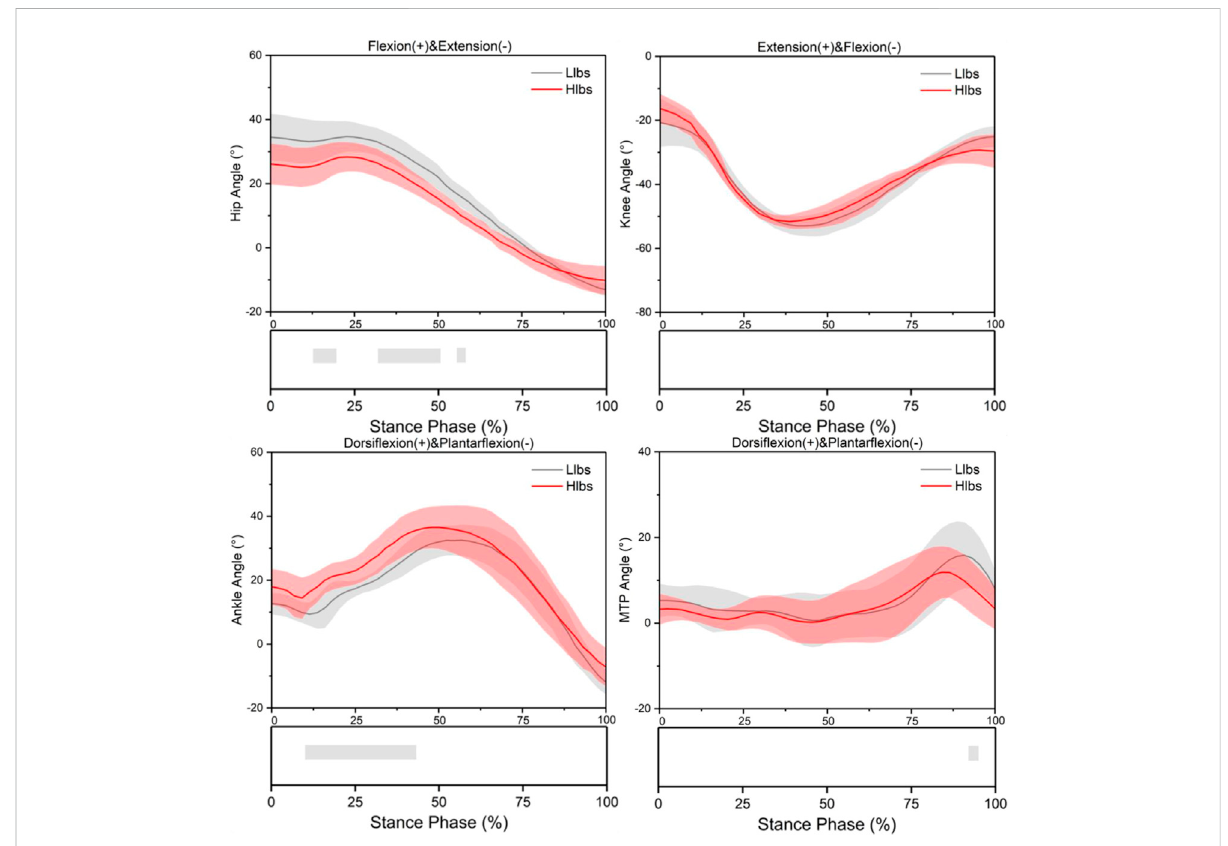
FIGURE 2 Lower limb joint angle waveforms of mean and standard deviation over the stance phase of two shoe conditions. Signi fi cant differences ( p < 0.05) are highlighted (grey horizontal bars at the bottom of the fi gure) during corresponding periods from SPM1d